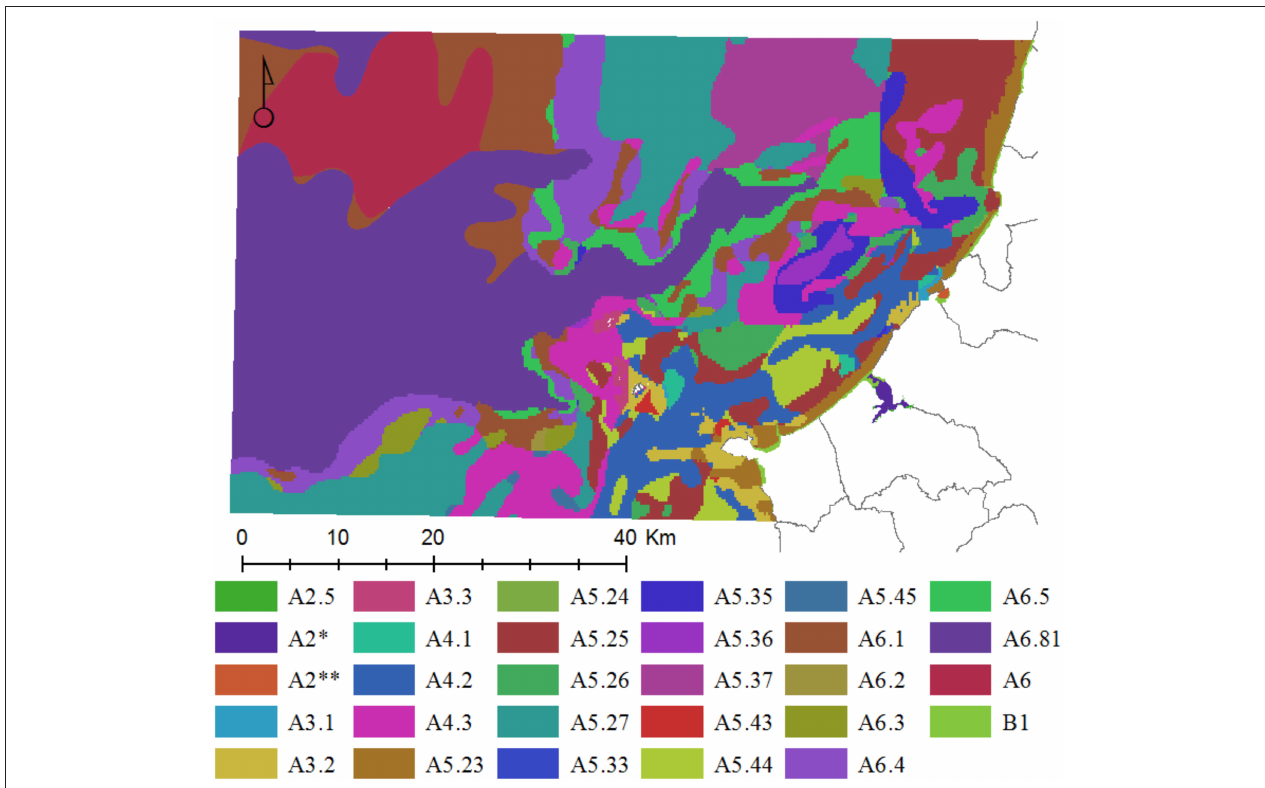
FIGURE 3 | Habitat map with the 28 marine benthic habitats identified in the complex Atlantic region between Peniche and Nazaré following the EUNIS habitat classification. (*Òbidos Lagoon **S. Martinho do Porto bay).